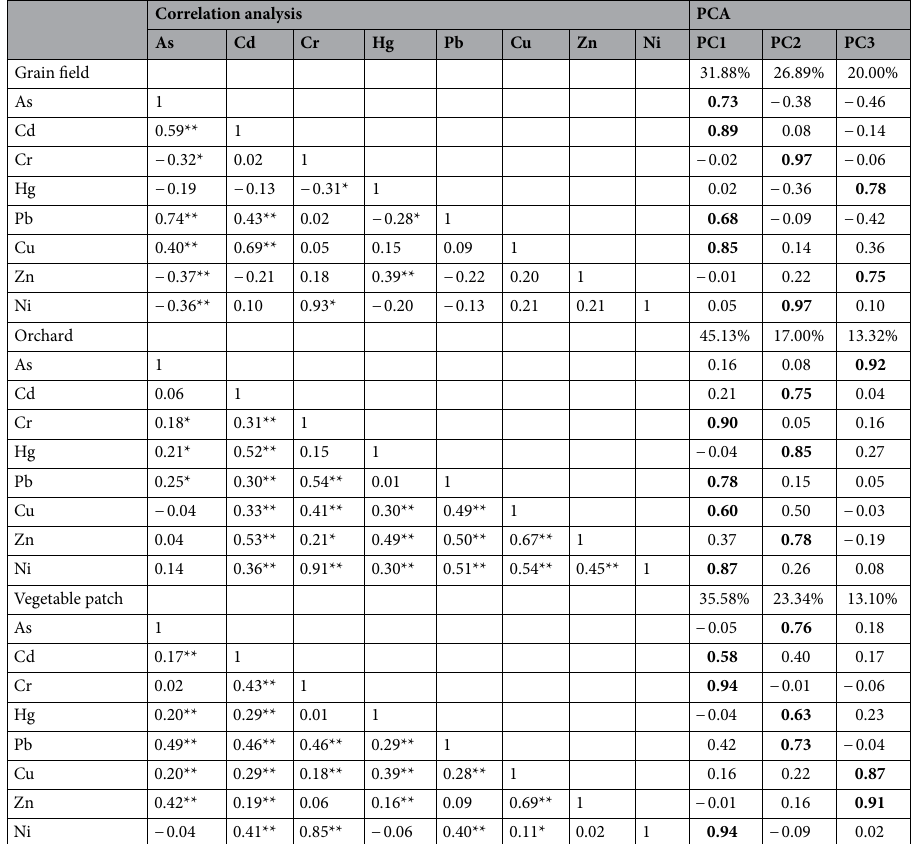
Table 2. Pearson correlation among trace elements and matrix of the principal component analysis (PCA) loadings for three farmland soils. KMO indexes of grain field, orchard, and vegetable patch were 0.68, 0.61 and 0.66 in PCA, respectively. All p values from Bartlett’s Test of Sphericity < 0.001. The eigenvalues > 1 were extracted. **Correlation is significant at the 0.01 level (2-tailed). * Correlation is significant at the 0.05 level